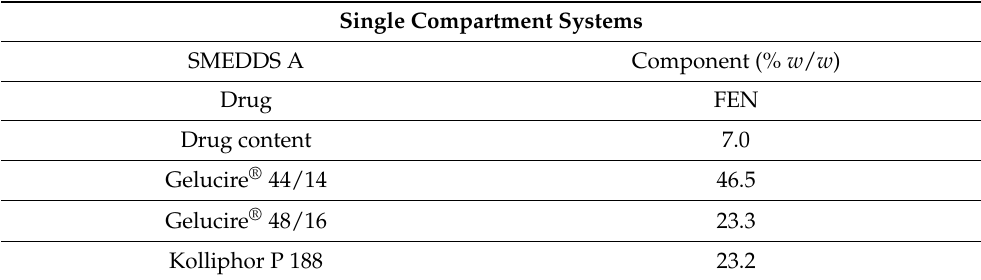
Table 4. Compositions of the FEN-loaded SMEDDS used for the single-compartment systems.